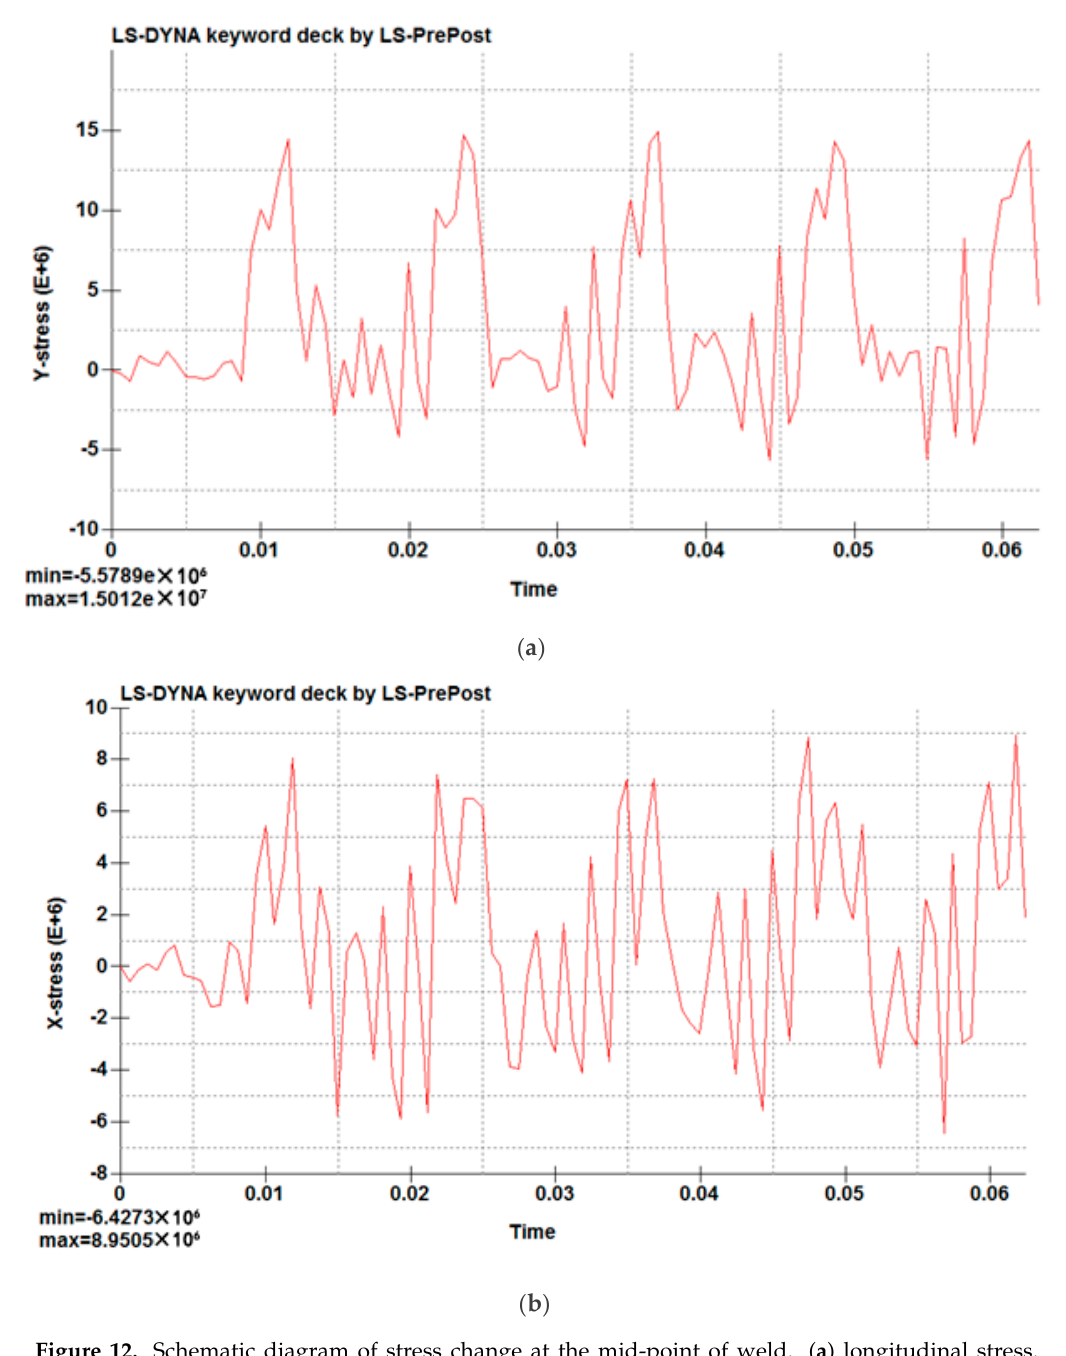
Figure 12. Schematic diagram of stress change at the mid-point of weld. ( a ) longitudinal stress. ( b ) transverse stress.